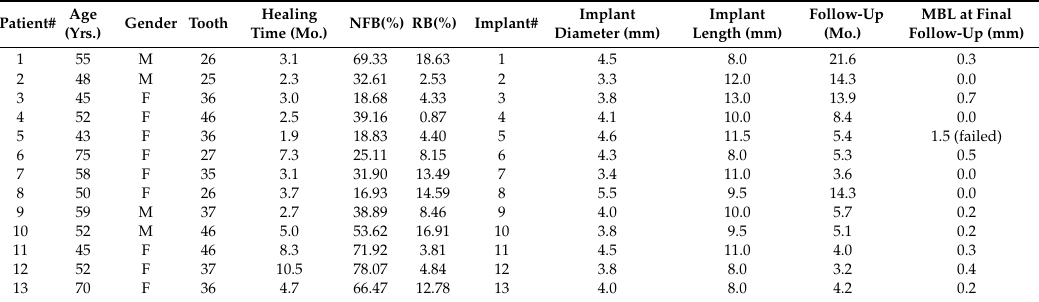
Table 1. Data concerning patient demographics, site of extraction, healing time, newly formed bone (NFB), residual bone (RB), placed implant, follow-up time, and marginal bone loss (MBL).